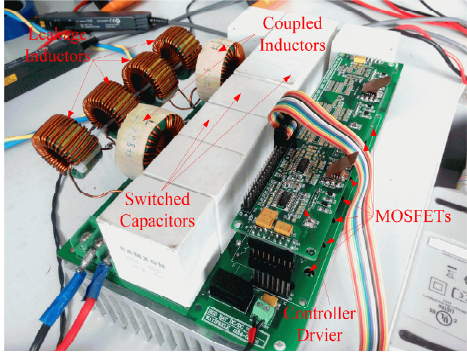
Figure 16. Picture of the laboratory setup.